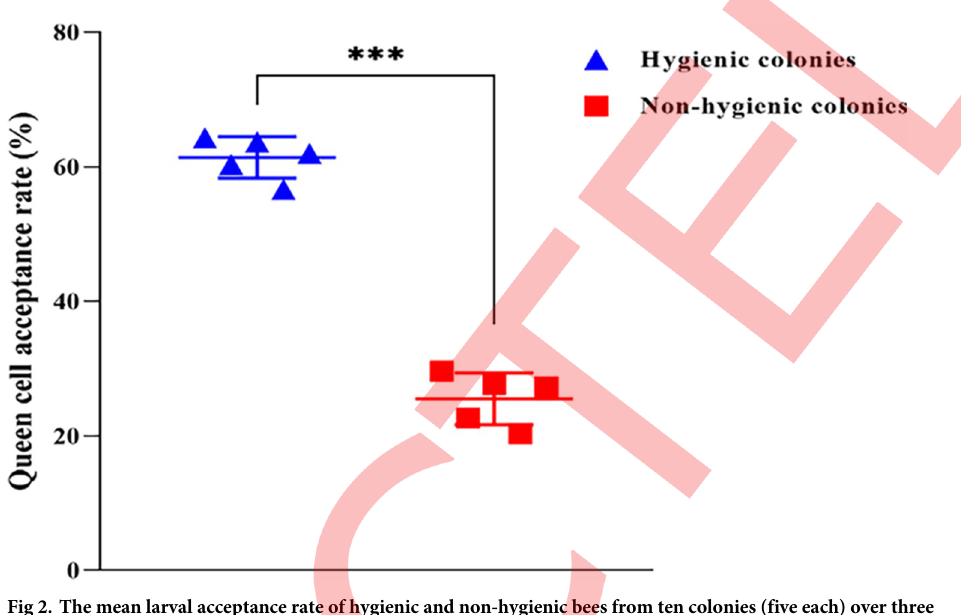
Fig 2. The mean larval acceptance rate of hygienic and non-hygienic bees from ten colonies (five each) over three collection time points.